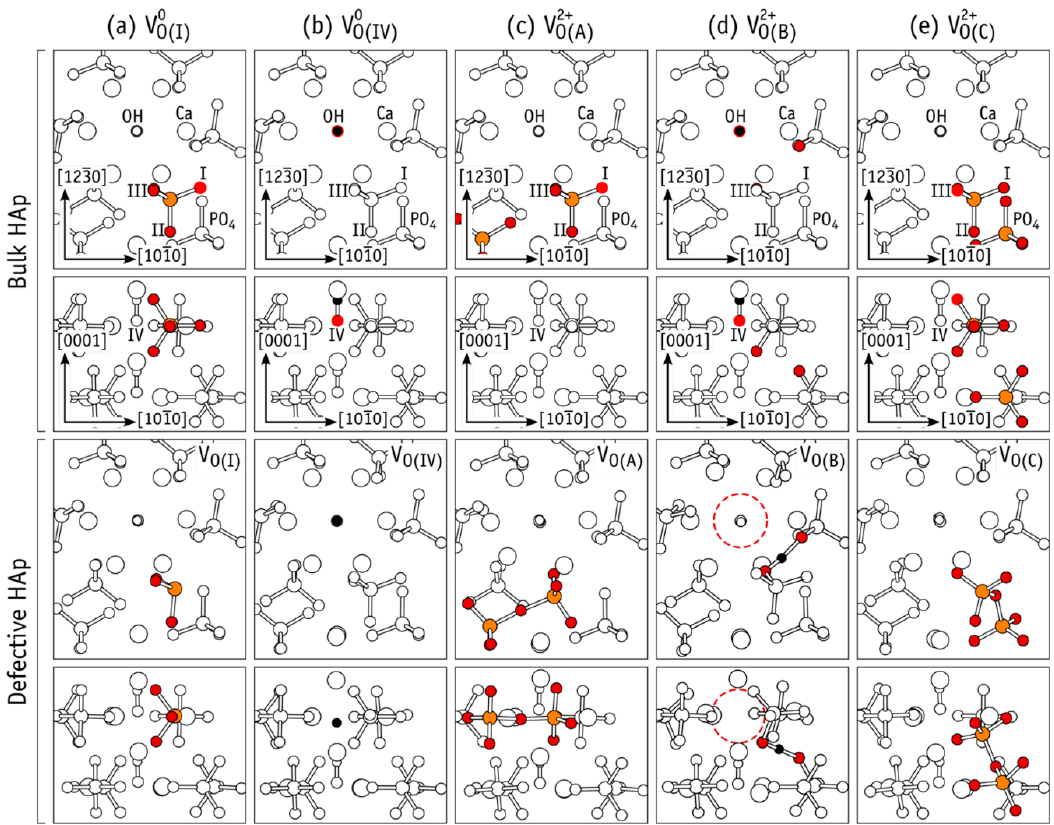
Figure 12. The structure formation of different types oxygen vacancies (V O(I) , V O(IV) , V O(A) , V O(B) , and V O(C) ) are presented in columns ( a – e ). The same structures are shown on each pair of rows: along the (1230) (upper row) and (0001) (lower row) directions of the hexagonal lattice. The colored atoms (orange—P, red—O, and black—H) are the core of the defect. The “Bulk HAp” figures demonstrate the vacancies produced by removing oxygen atom (bright red). The “Defective HAp” figures present the resulting structures after atomic relaxation. Reprinted with permission from [35]. Copyright (2019) American Chemical Society.